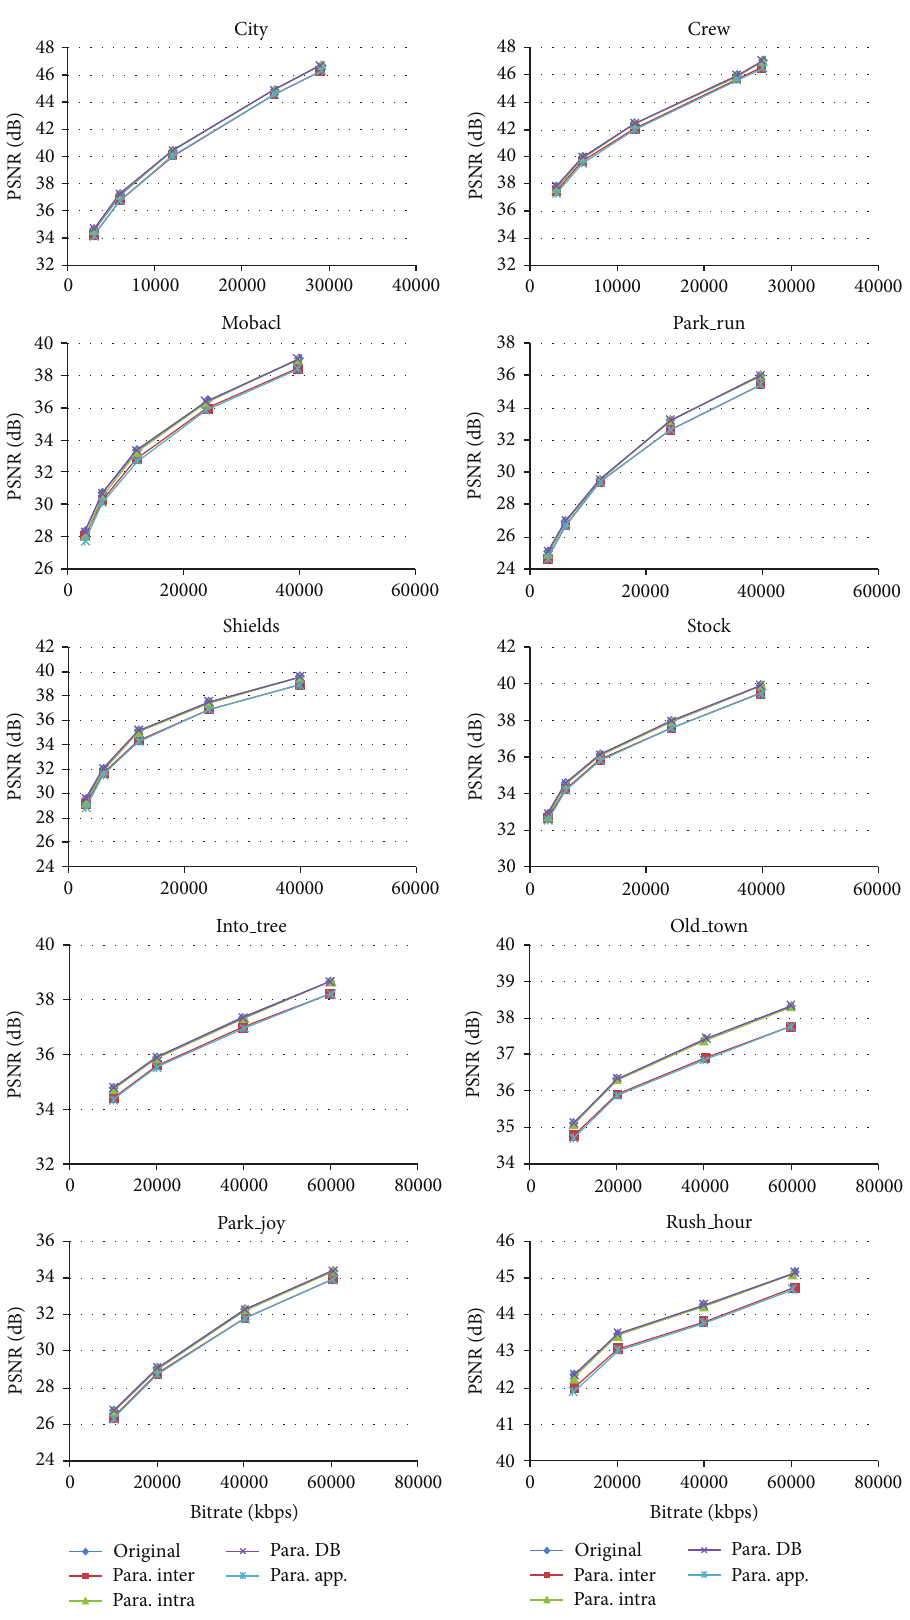
Figure 15: RD performance with different